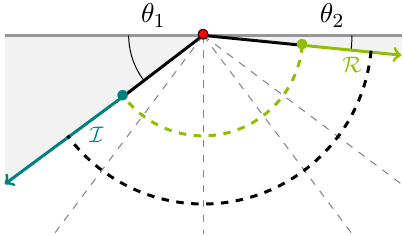
Figure 3. Embedding of a KR braneworld with two positive tension branes in the black string geometry. The dashed black curve is the black string horizon separating the exterior and interior regions. The dashed green curve connecting the two branes is a putative RT